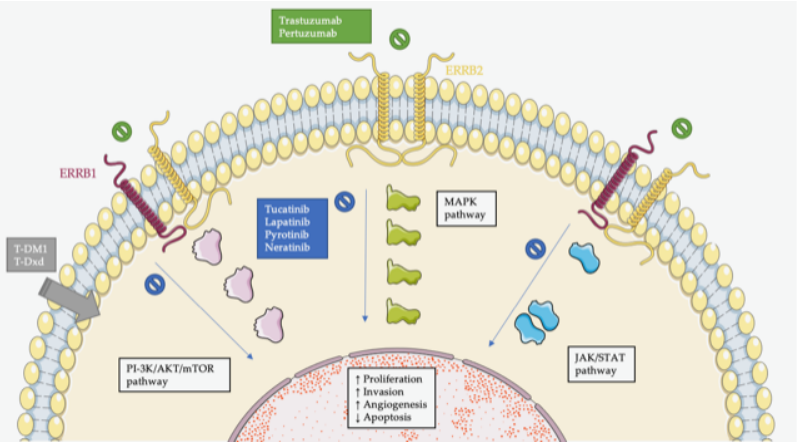
Figure 1. Molecular biology of HER2 receptor and mechanisms of action of main available drugs. Activation of HER2 by overexpression (enabling uncontrolled homo- or heterodimerization) or by activating mutations leads to constitutive activation of MAPK, PI-3K/AKT/mTOR, Src, and JAK/STAT pathways. Available drugs block this activation by inhibition of the dimerization or by inhibition of the tyrosine kinase domain of the receptor. T-DM1 and T-Dxd exert their cytopathic effects by liberation of chemotherapy in high concentrations in tumors expressing HER2.